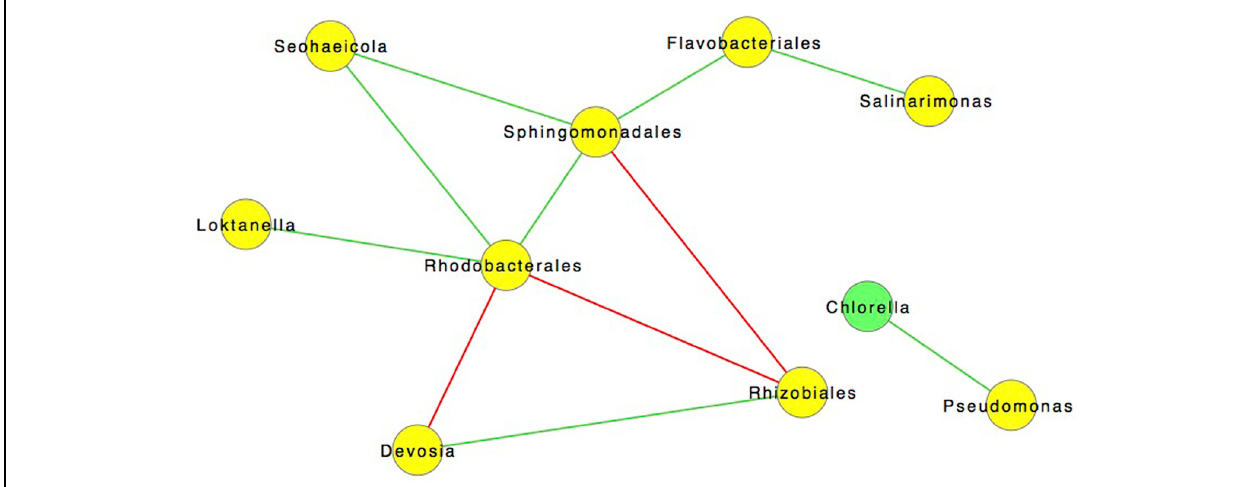
FIGURE 7 | SparCC network map showing significant ( p < 0.05) of 122 Interactions with a 0.85 correlation between different OTUs incorporating all time points. Green lines are indicative of positive interactions while red lines are